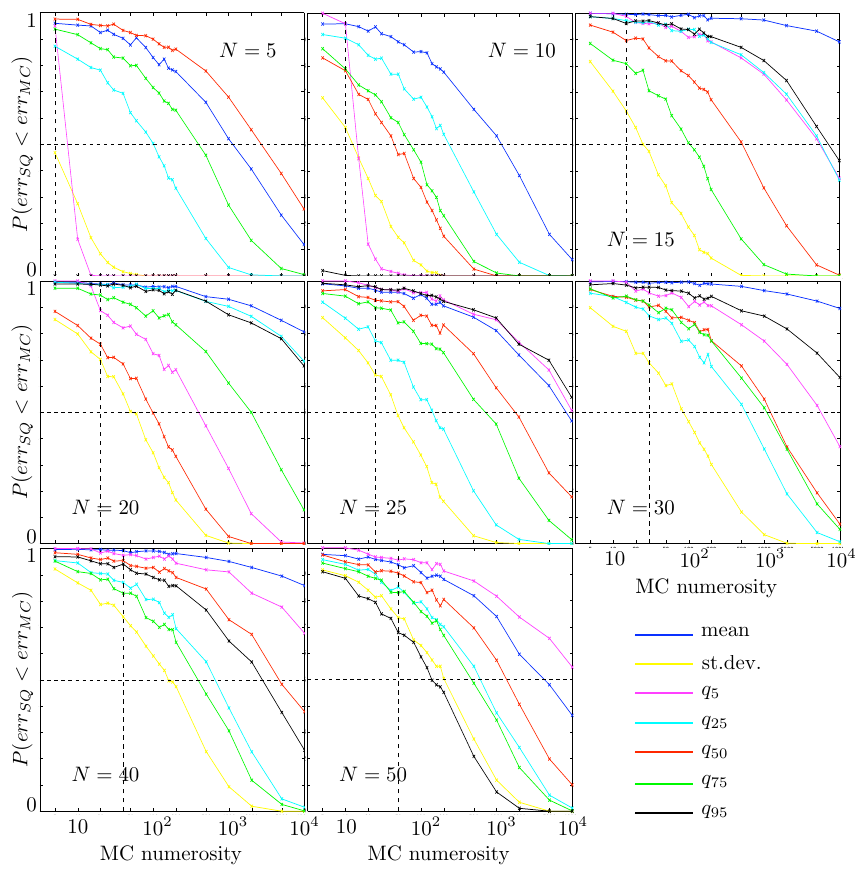
Fig. 5. Comparison between the SQ and MC simulations. On the x axis there is the numerosity of the MC, in logarithmic scale; on the y axis there is the probability that err SQ < err MC , where err SQ = output probability distribution g , p SQ and p MC are its estimates given by SQ and MC, respectively. The curves represent the results for various parameters: mean, standard deviation and the 5%, 25%, 50%, 75%, 95% quantiles. The horizontal dashed line marks the value 0.5 of probability. Different graphs refer to different values of the numerosity N of the SQ. In each graph, a vertical dashed line is drawn in correspondance of the MC numerosity equal to N